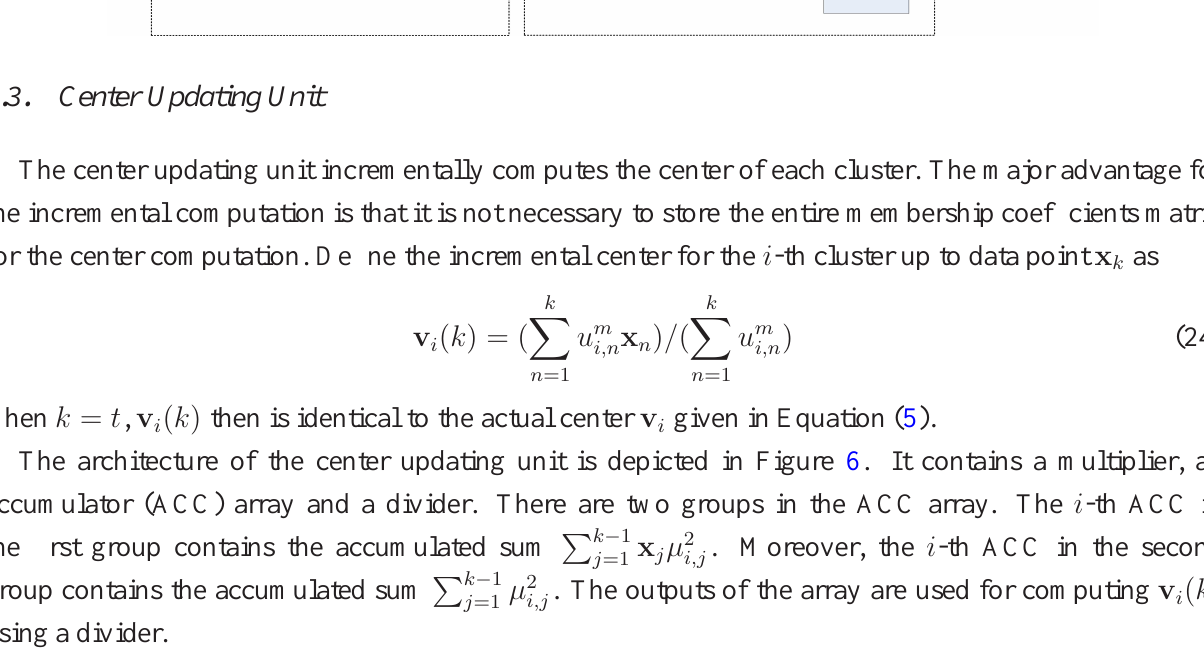
Figure 6. The architecture of center updating